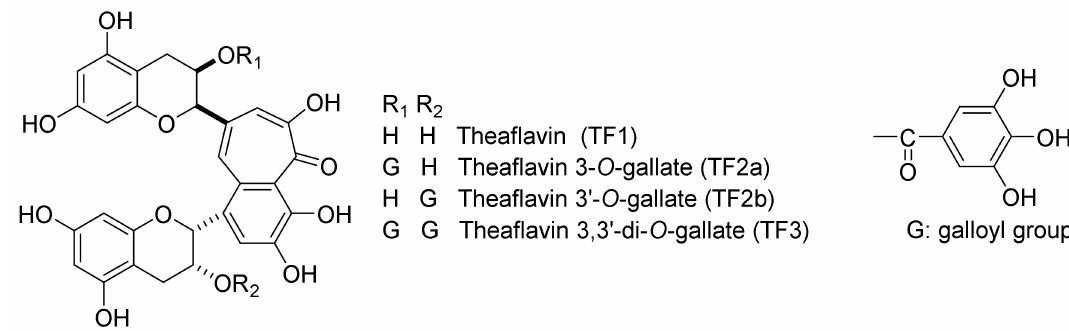
Figure 1. Chemical structures of TF1, TF2a, TF2b, and